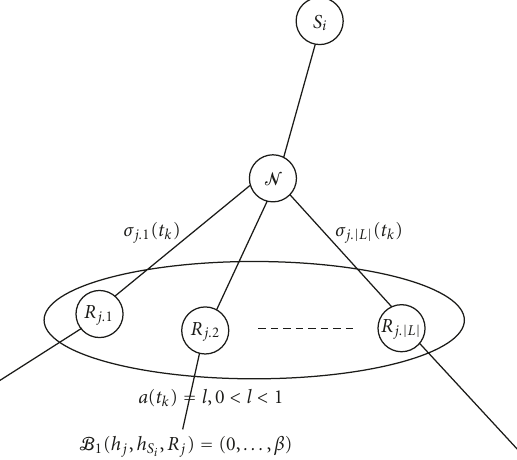
Figure 8: Example 3. Extensive form representation of a cooperative game with imperfect information. R j. 1 , ... , R j. | L | denote decision nodes of the relay, that is, the di ff erent power levels that Nature N will randomly selects for R j . S i denotes source node i